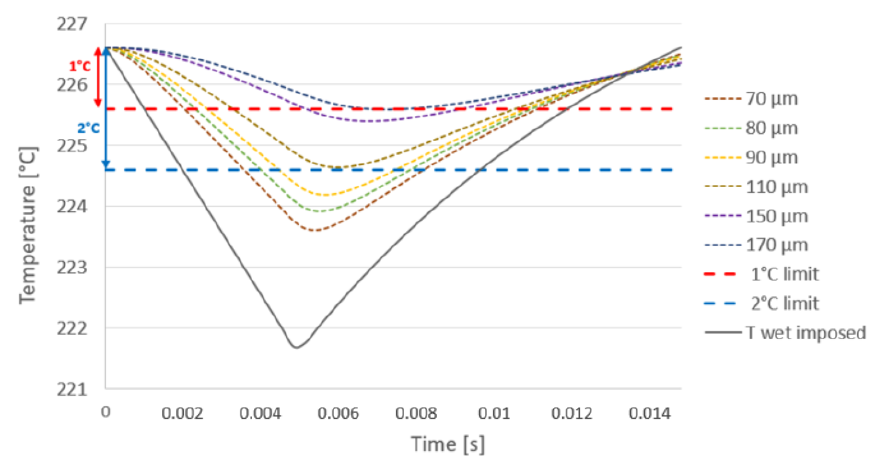
Figure 20. Example of the determination of the limit thickness at y = y 0 for 20 bar pressure, a 120 µm bubble diameter was imposed. This problem–solution was solved with the following values: N x = 50, N y = 200, n = 50, t g = 0.005s, t w = 0.01s, , ∆ t = 0.00031s, P = 1 bar, I = 400A, ∆ T = 5 ◦ C, C P = 502 J/K · kg, λ = 15 W/m · K, ρ = 7960 kg/m 3 .